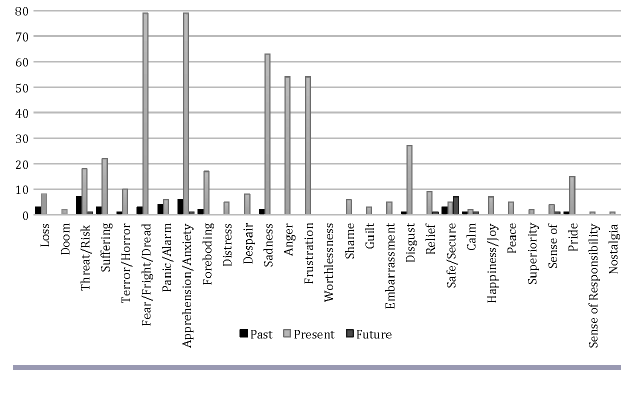
Fig. 4. Total emotion counts between 16 October 2000 and 26 August 2001.